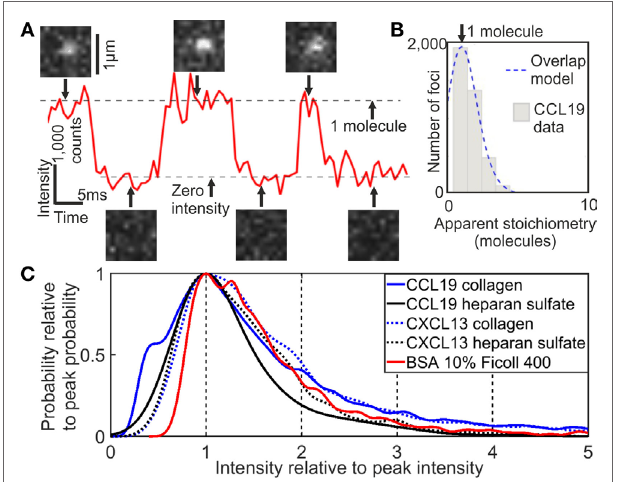
FigUre 3 | Simulations of chemokine data. (a) Sample simulation images, shown with and without Gaussian white noise added. Scale bar 1 µm. (B) Two-gamma distribution fit (red) to diffusion coefficients found from a simulation of 1.6 and 10 µm 2 s − 1 data with Gaussian white noise. (c) Histograms showing the distribution of simulated 0 µm 2 s − 1 data with (red, overlaid) and without (blue) Gaussian white noise. (D) Diffusion coefficient distribution from a simulation of 0 and 9 µm 2 s − 1 data with Gaussian white noise. Fitted populations are shown in black for the immobile, red for the mobile, and blue for the combined fit. Shaded areas indicate one